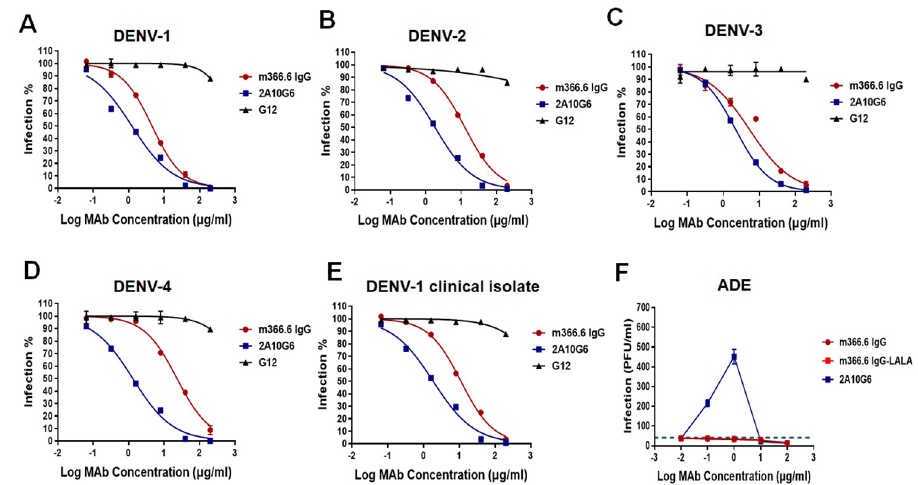
Fig 3. Neutralization and ADE effects of antibodies against different serotypes DENV. (A-E). DENV1-4 was mixed with 5-fold serial dilutions of mabs. Then neutralization activity was evaluated by plaque reduction assays in triplicates using BHK21 cells. Results were exhibited by percentage of plaques reduction and the independent neutralization experiments were performed in duplicate. (F) DENV-1 was incubate with 10-fold serial dilutions of mAbs before added to K562 cells. Virus in the supernatant of infected K562 cells was quantified in a plaque assay. The data were shown as means ± SD. The dotted line indicates the limit of detection. Results are representative of three independent experiments.